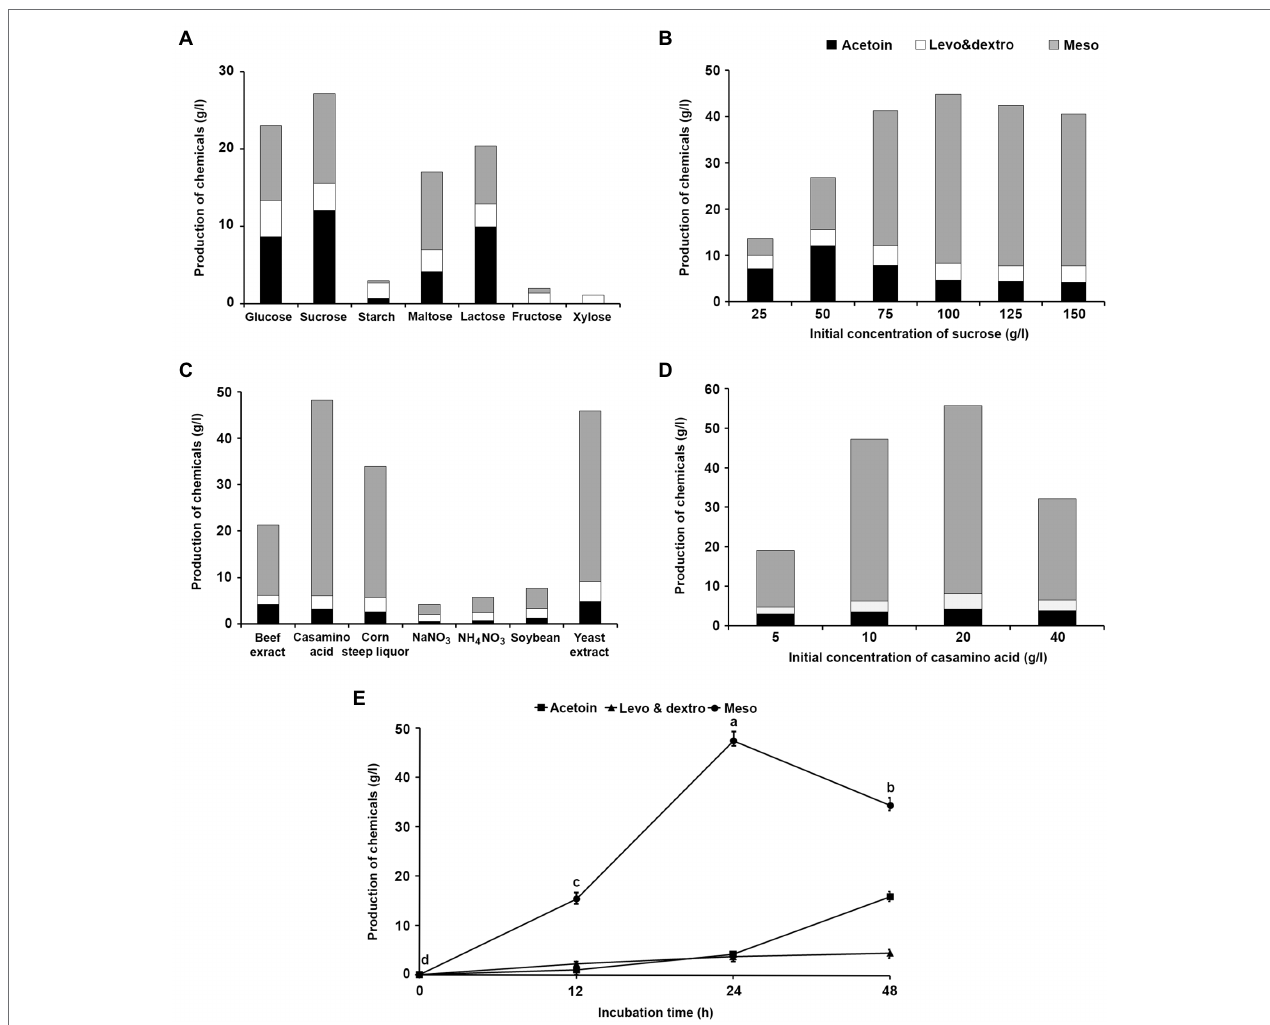
FIGURE 2 | Effect of different carbon and nitrogen sources on the production of acetoin and 2,3-BDO by K. pneumoniae JCK-2201. The data show the means ± SD ( n = 3). Black bar: acetoin, white bar: levo-2,3-BDO and dextro-2,3-BDO, gray bar: meso-2,3-BDO. (A) Carbon sources. (B) Sucrose concentration. (C) Nitrogen sources. (D) Casamino acid concentration. (E) Comparison of production according to incubation time when cultured in optimum medium containing 100 g/L sucrose and 20 g/L casamino acid. Lower-case letters indicate statistically significant differences as compared to meso-2,3-BDO production by incubation time ( p < 0.05) according to Tukey’s HSD